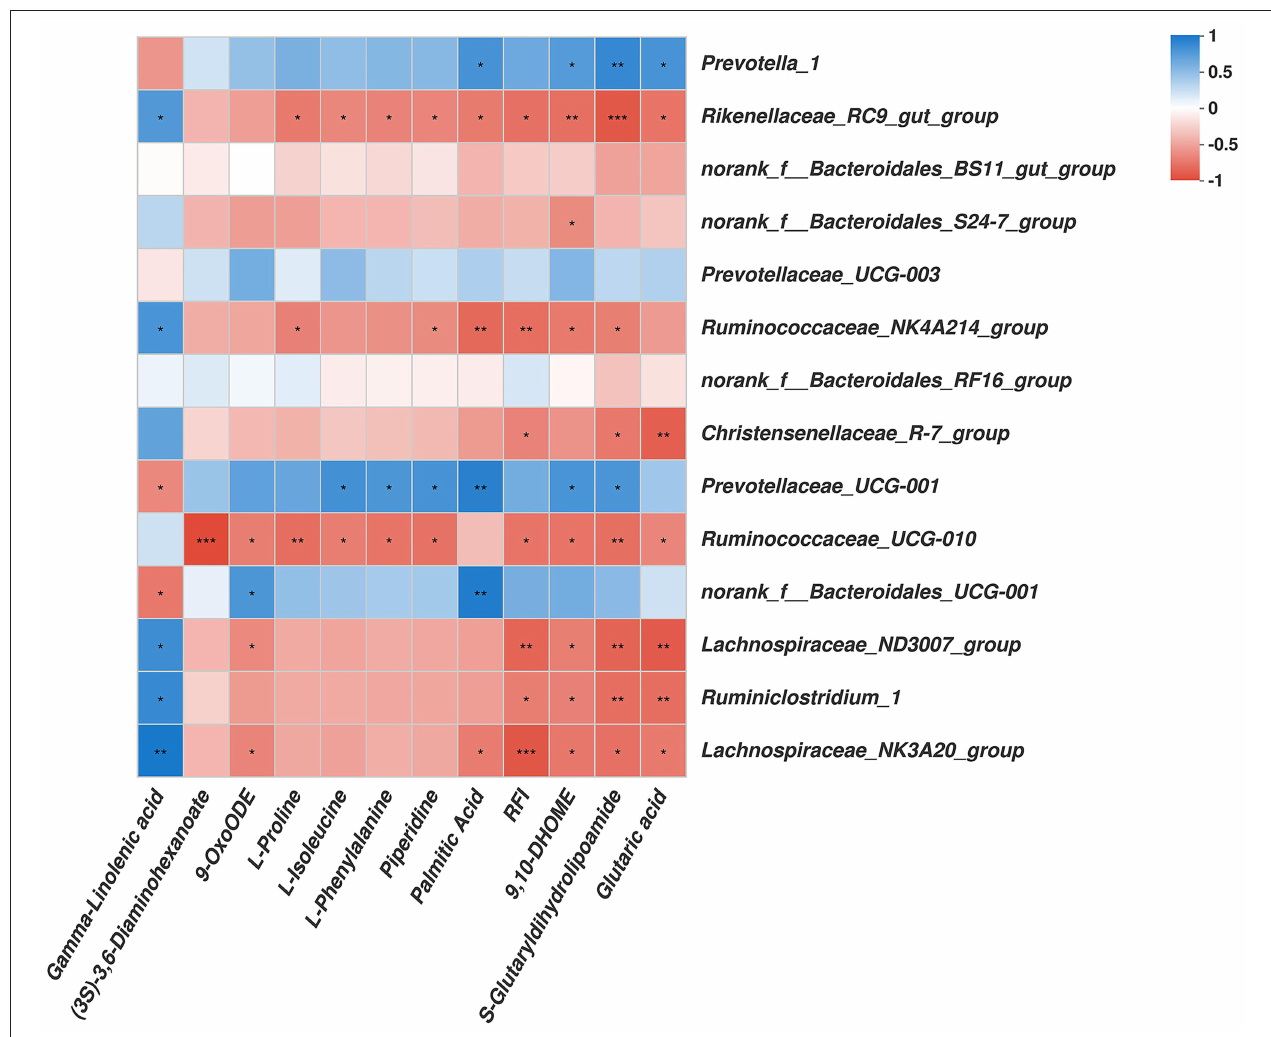
FIGURE 4 | Correlation analysis among rumen genera bacteria, rumen metabolites affected by RFI, and the RFI. Cells are colored based on Spearman’s correlation coefficient: Blue represents a positive correlation; red represents a negative correlation. Significant correlation: *** P ≤ 0.001, **0.001 < P ≤ 0.01; * 0.01 < P ≤ 0.05. Therefore, it is imperative that we select LRFI cattle that